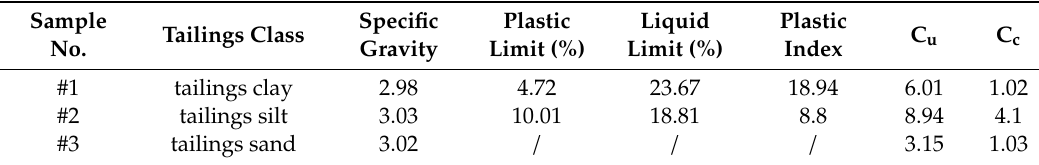
Table 2. Physical index of the test tailings.